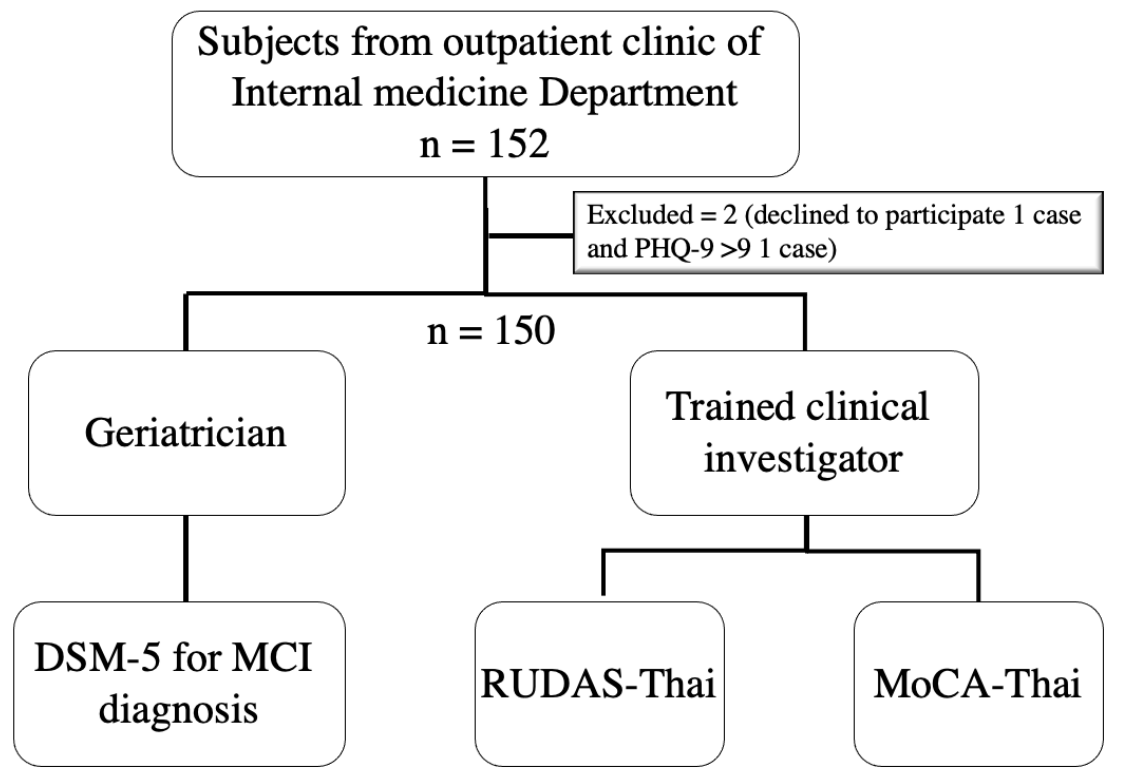
Figure 1. Flow of the study. Note: DSM-5; Diagnostic and Statistical Manual of Mental Disorders, MCI; mild cognitive impairment, RUDAS-Thai; Thai version of Rowland Universal Dementia Assessment Scale, MoCA-Thai; Thai version of Montreal Cognitive Assessment, PHQ-9; Thai version of the Patient Health Questionaire-9. Adapted from [29], Manjavong, M.; Limpawattana, P.; Sawanyawisuth, K. Performance of the Rowland Universal Dementia Assessment Scale in Screening Mild Cognitive Impairment at an Outpatient Setting. Dement. Geriatr. Cogn. Disord Extra 2021 , 11 , 181–188.